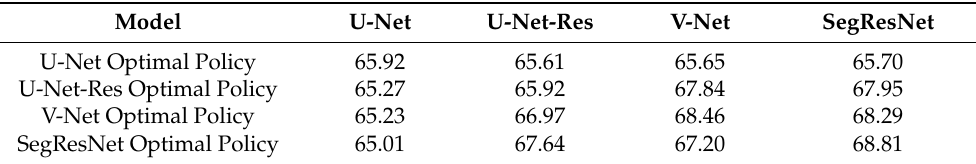
Table 5. BraTS transferability experiments showing the DSC test performance of neural networks trained using optimal policies found from the search with the other neural networks. (IoU version of this table is found in Appendix